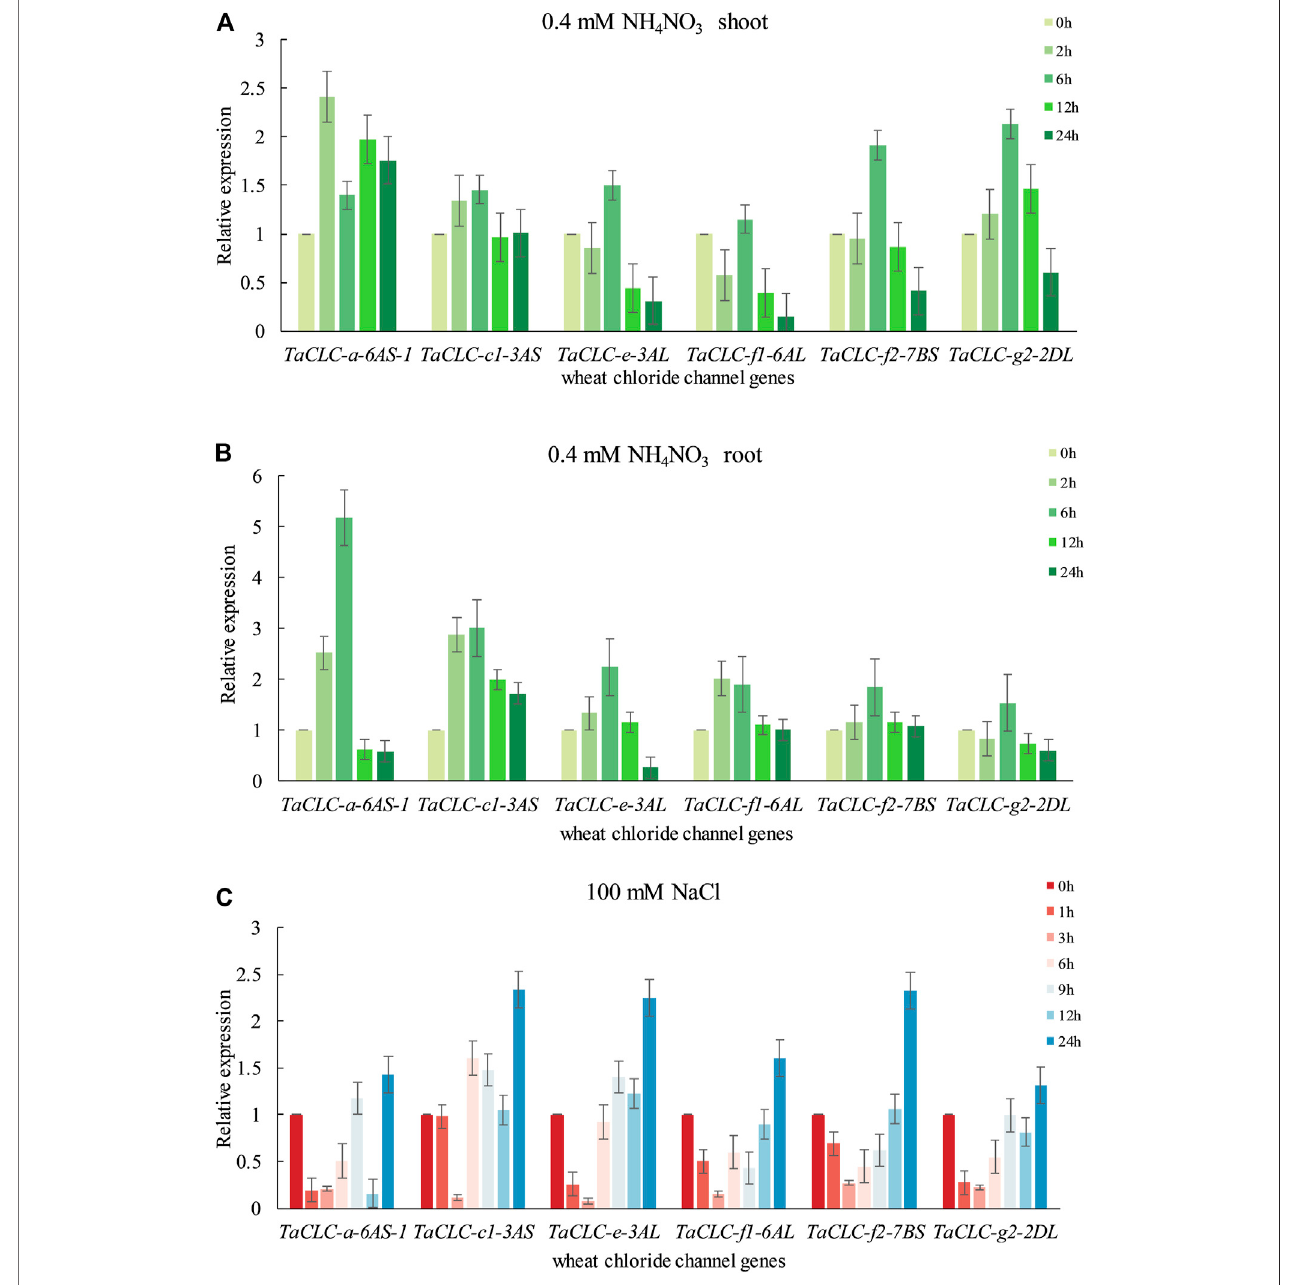
FIGURE 7 | Quantitative real-time PCR validation of TaCLC genes in wheat seedlings under different stresses. (A) Expression of TaCLC genes in the wheat shoot tissueafter0.4